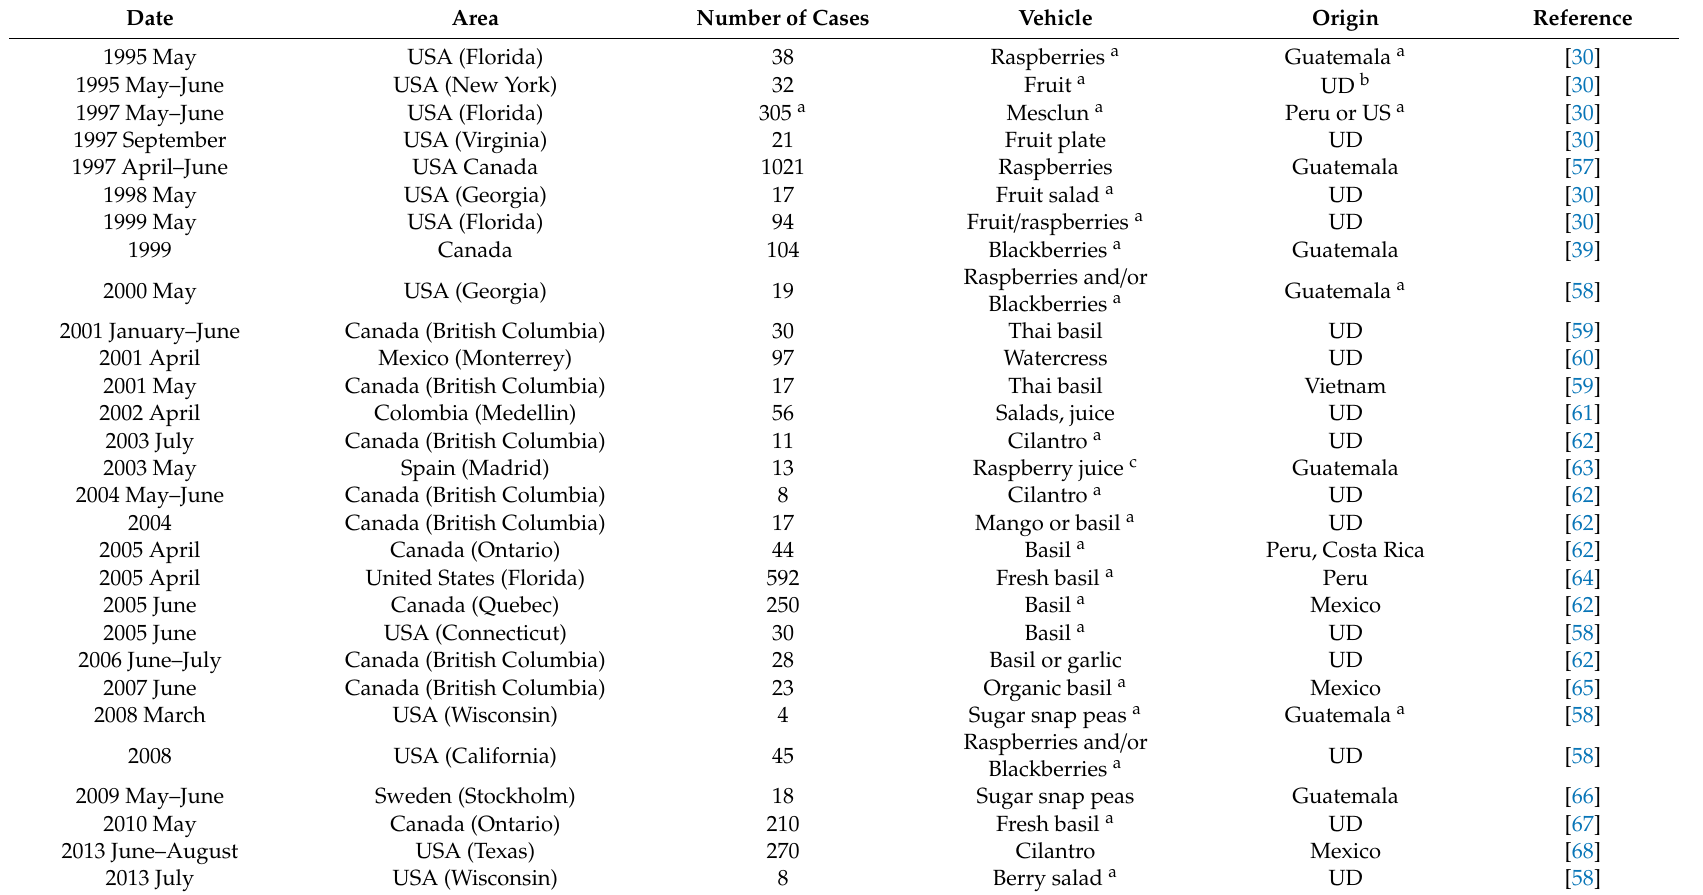
Table 1. Summary of additional cyclosporiasis outbreaks associated with fresh produce consumption reported from 1995 to